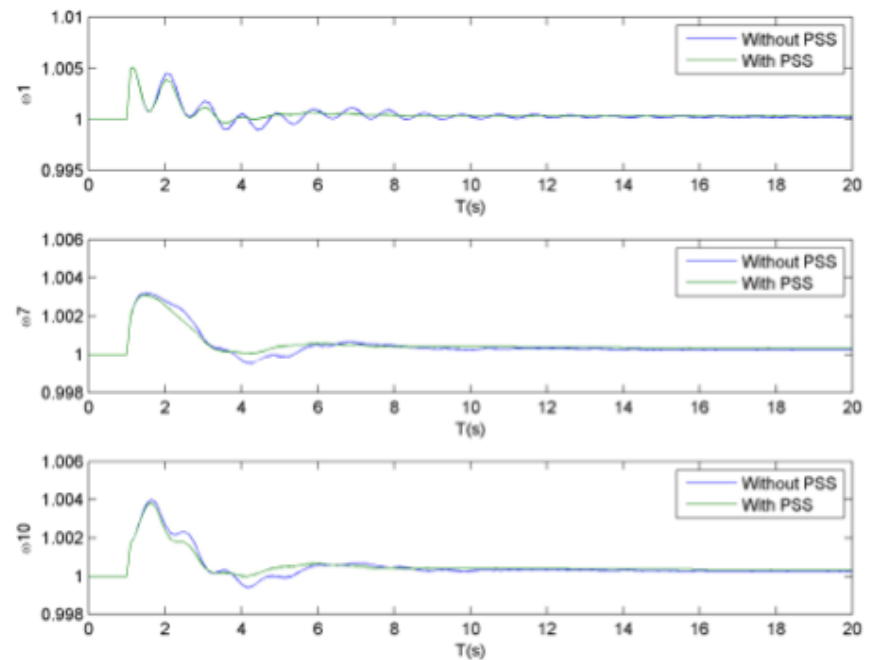
Figure 12. Response of the velocity of machine 1 of the SING after a fault occurs at busbar 33.